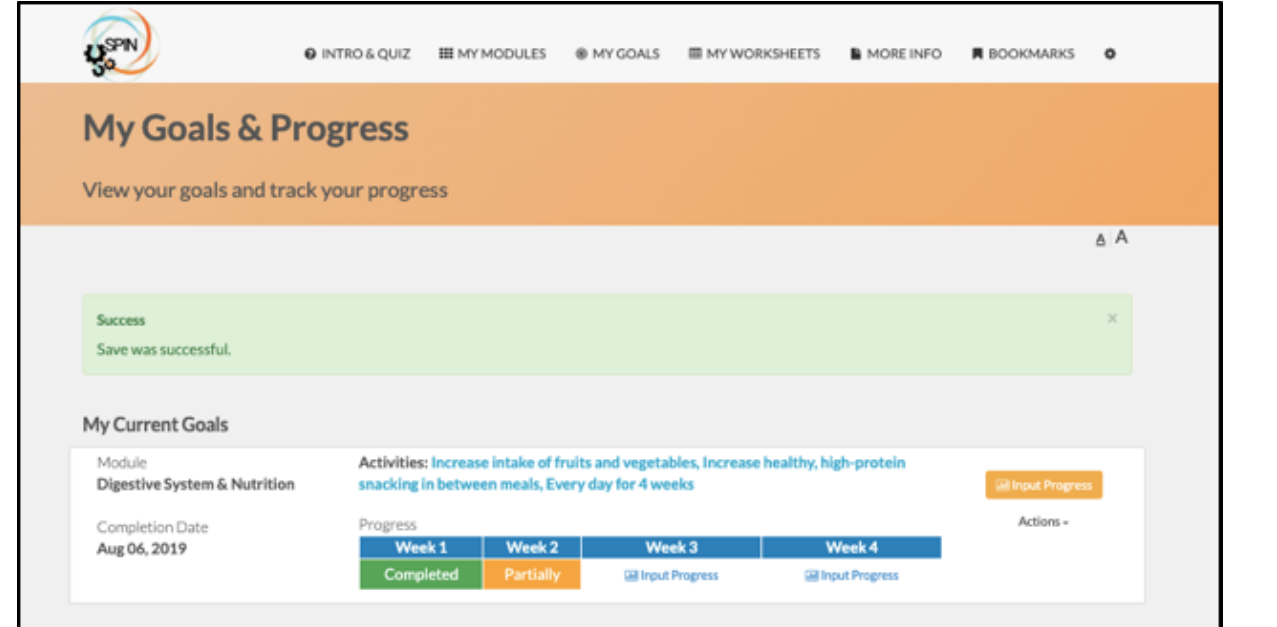
Figure 7. Goals and progress tracking